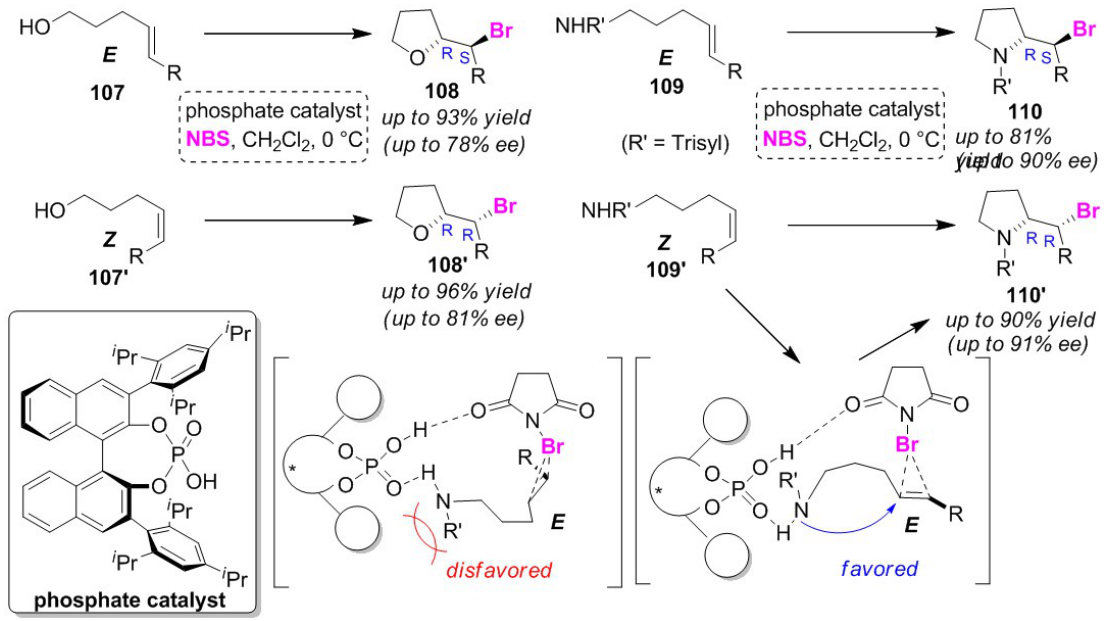
Figure 51. Enantioselective bromocyclizations of E -olefinic and Z -olefinic alcohols ( 107 and 107 ′ ) and amines ( 109 and 109 ′ ) using a phosphate catalyst.